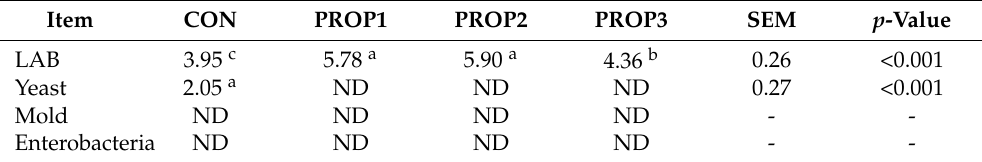
Table 6. Microbiological analysis results of alfalfa silages, log10 CFU/g.